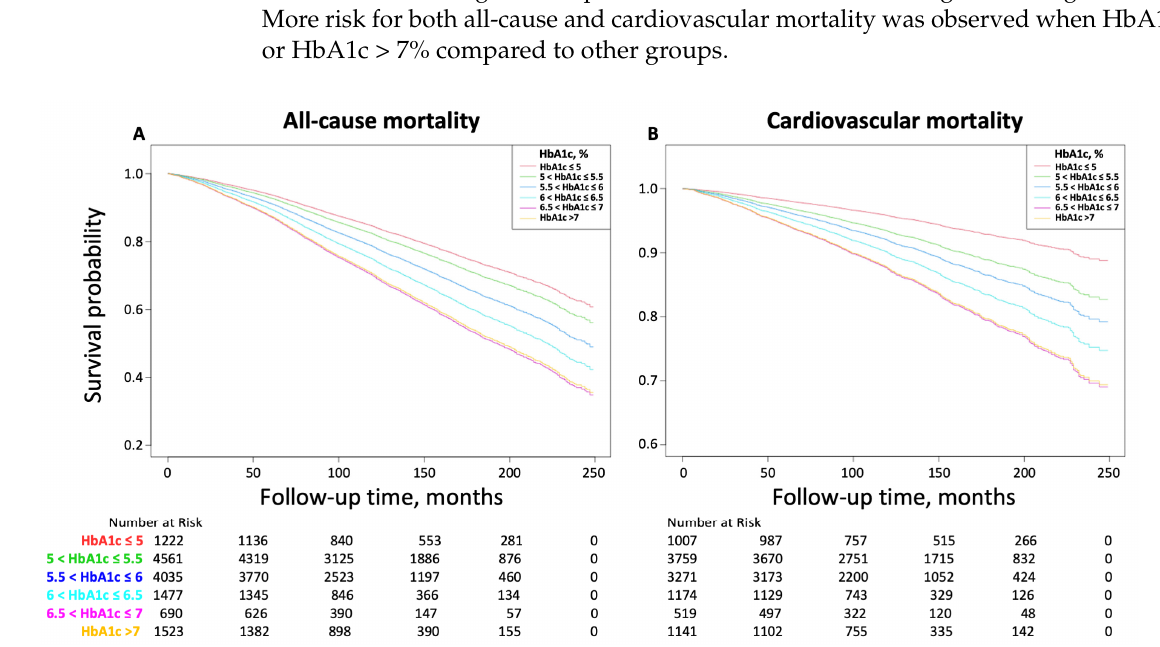
Figure 2. Kaplan–Meier survival curves of HbA1c with all-cause ( A ) and cardiovascular ( B ) mortality. HbA1c, glycated hemoglobin A1c.